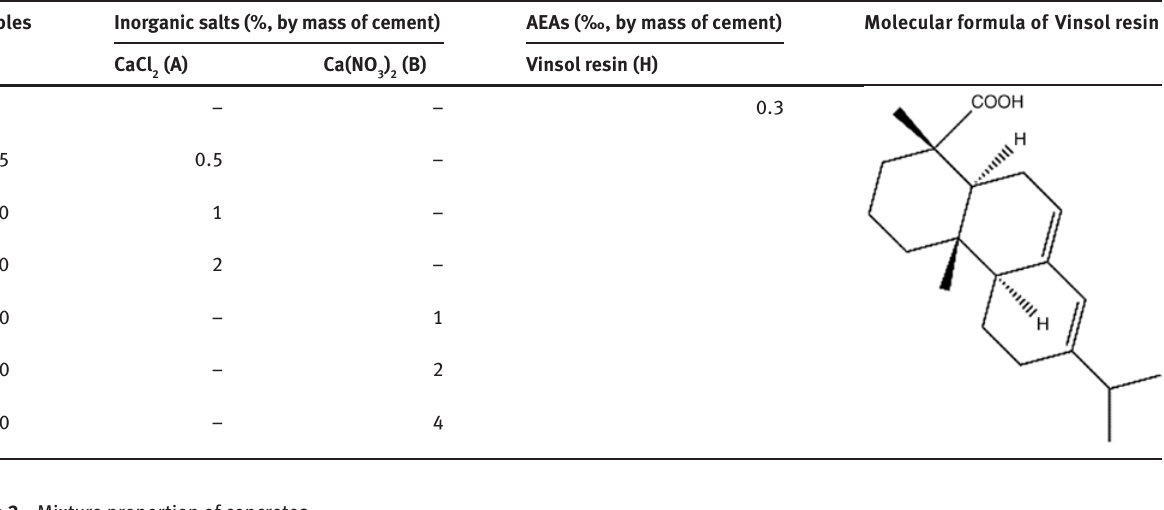
Table 2: Mixture proportion of concretes. W / C Water (kg/m 3 )